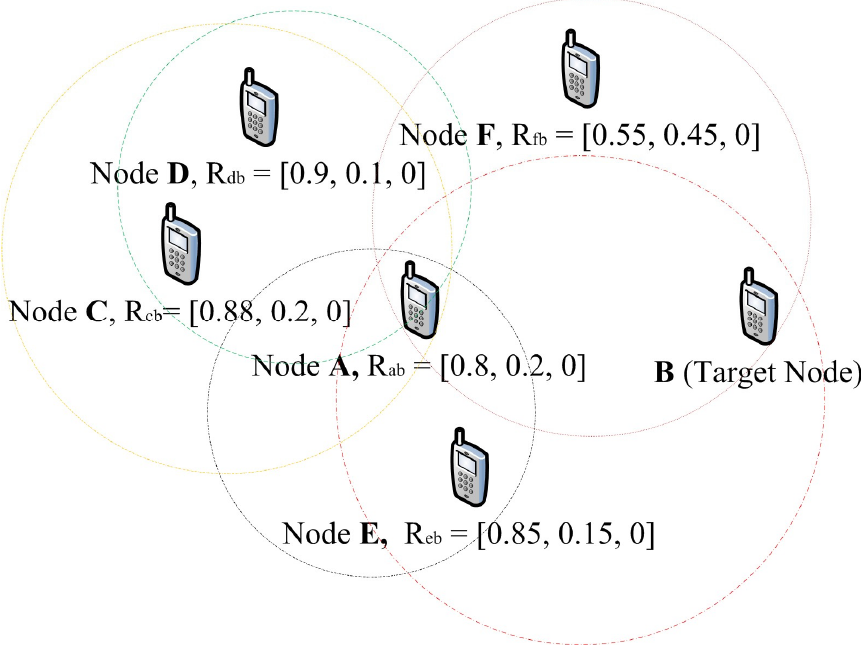
Figure 3. A typical scenario of second-hand reputations from neighbours. Table 2. Second-hand reputations verification scenario. Recommending